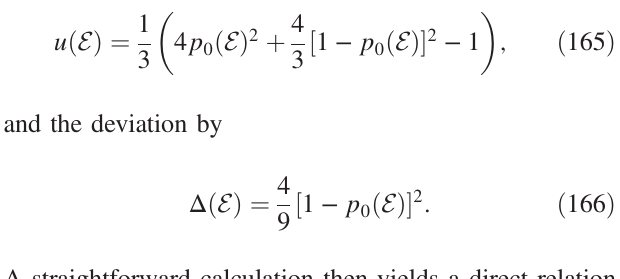
ffiffiffiffiffiffiffiffiffiffi p Δ ð E Þ ; ð 161 Þ